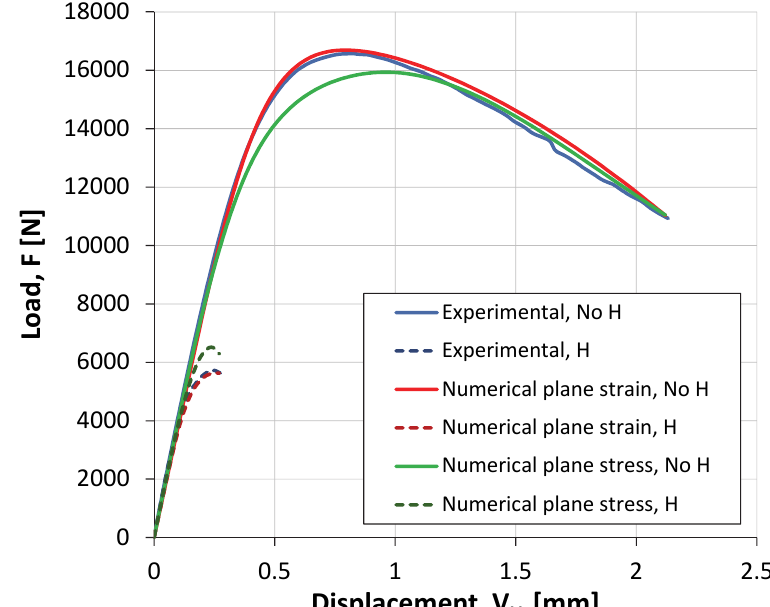
Figure 6: F-V LL curves from experimental tests and numerical simulations, for plane strain and plane stress. Solid lines plot data without hydrogen, dashed lines with